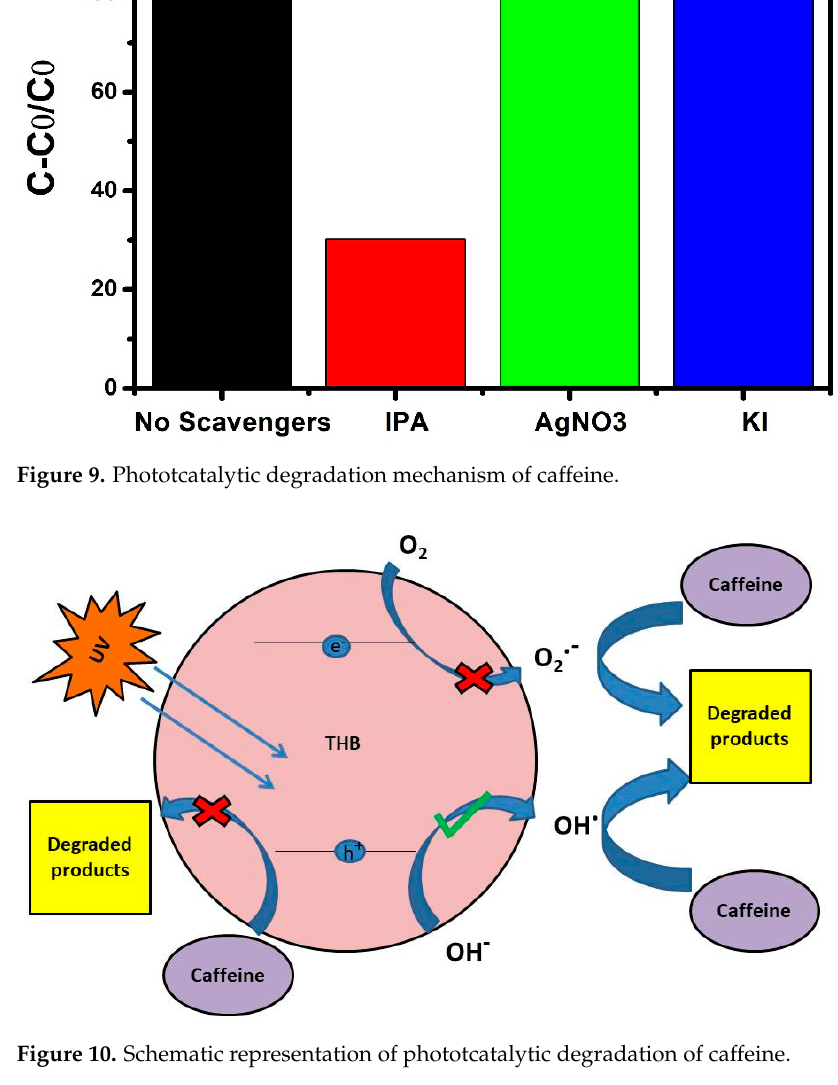
Figure 10. Schematic representation of phototcatalytic degradation of ca ff eine .